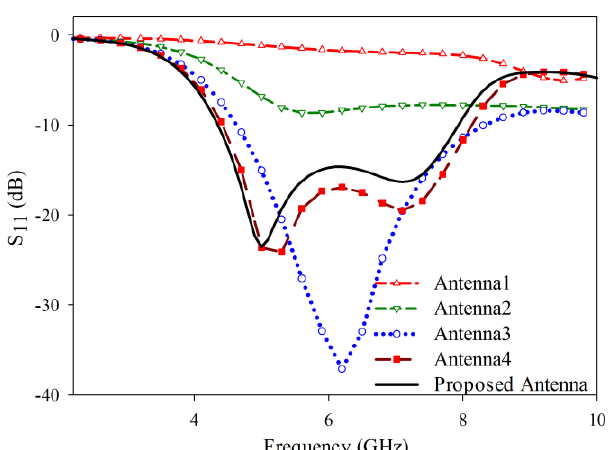
Figure 4: Comparative simulated S 11 graphs of the LPMA design steps